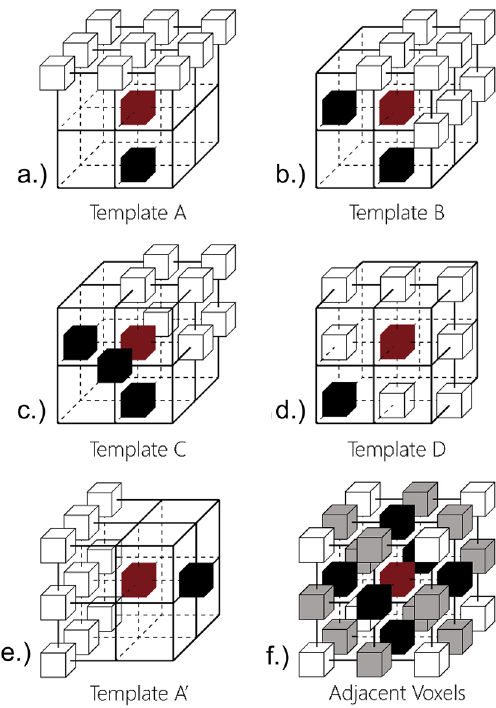
Figure 2. ( a – d ) show the four base template types used in step 7. One variant of template A is shown in ( e ). Each template assesses the 26 neighbour voxels in a 3 × 3 × 3 space around a candidate (red), discriminating between void voxels (white) and object voxels (black). ( f ) shows the 26-neighbourhood of the red voxel, with face-, edge-, and corner-connected voxels in black, grey and white